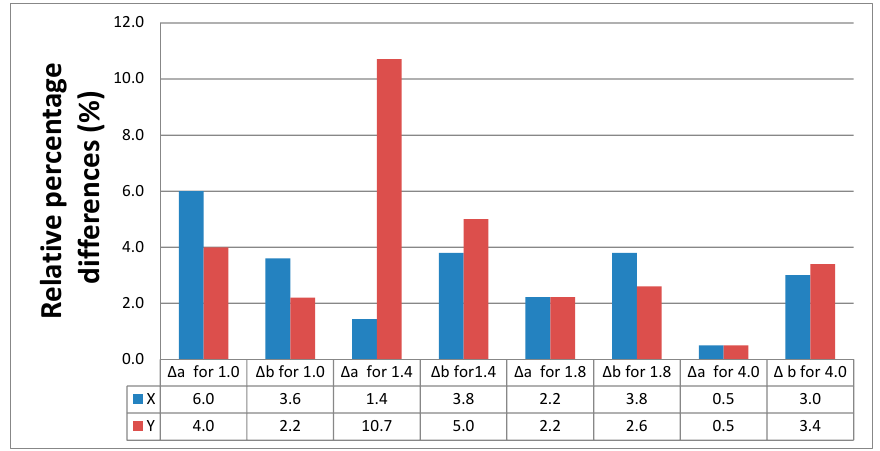
Figure 12. Relative percentage differences in thickness and width of the PLA + bronze specimens.